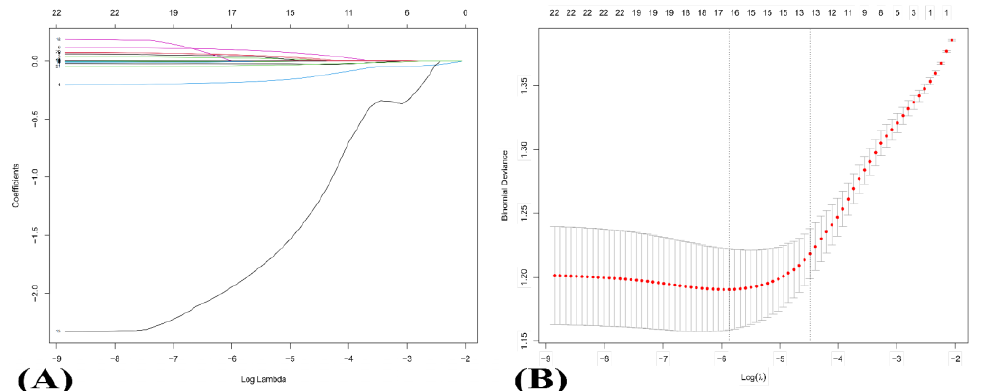
Figure 2. Variable selection using the LASSO logistic regression model. ( A ) LASSO coefficients of 22 candidate variables. The different color lines stand for trajectories for various variables at increasingly higher levels of λ. ( B ) The optimal penalization coefficient (λ) identification in the LASSO model was achieved by 10−fold cross−validation and the minimum criterion. The left vertical line represents the minimum error, and the right vertical line represents the cross−validated error within one standard error of the minimum. The red dotted line reflects changes of the mean squared error, defined as the sum of variance and squared bias, at different levels of λ. Abbreviation: LASSO, least absolute shrinkage and selection operator.